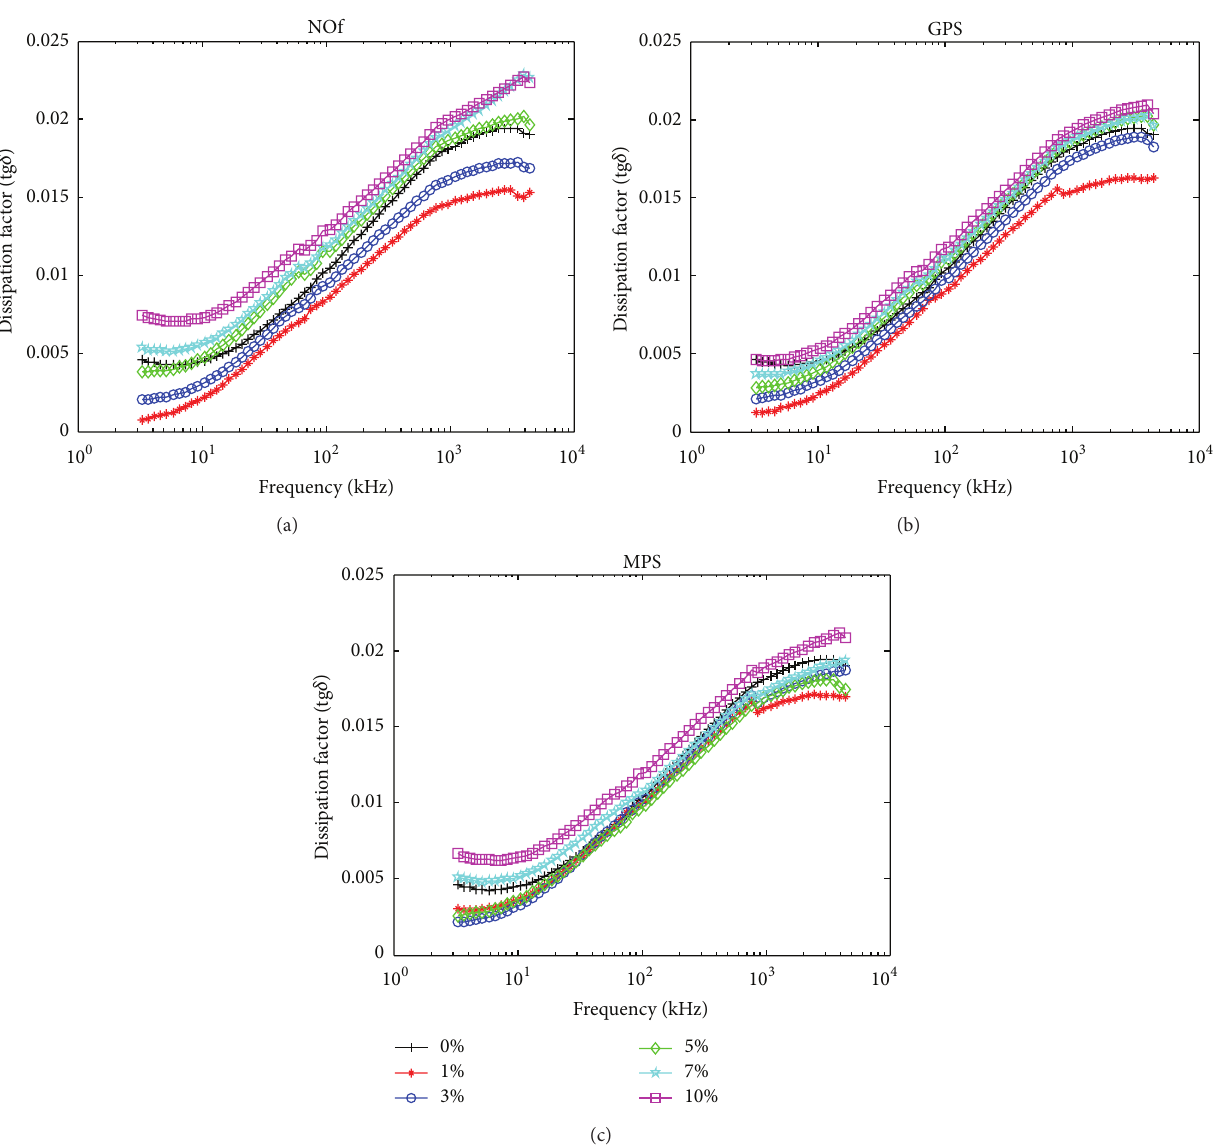
Figure7:Dissipationfactor(tan 𝛿 )asafunctionoftheappliedfrequency( 𝑓 )forsystemsfilledwithnonfunctionalized(a),GPSfunctionalized (b), and MPS functionalized (c) alumina